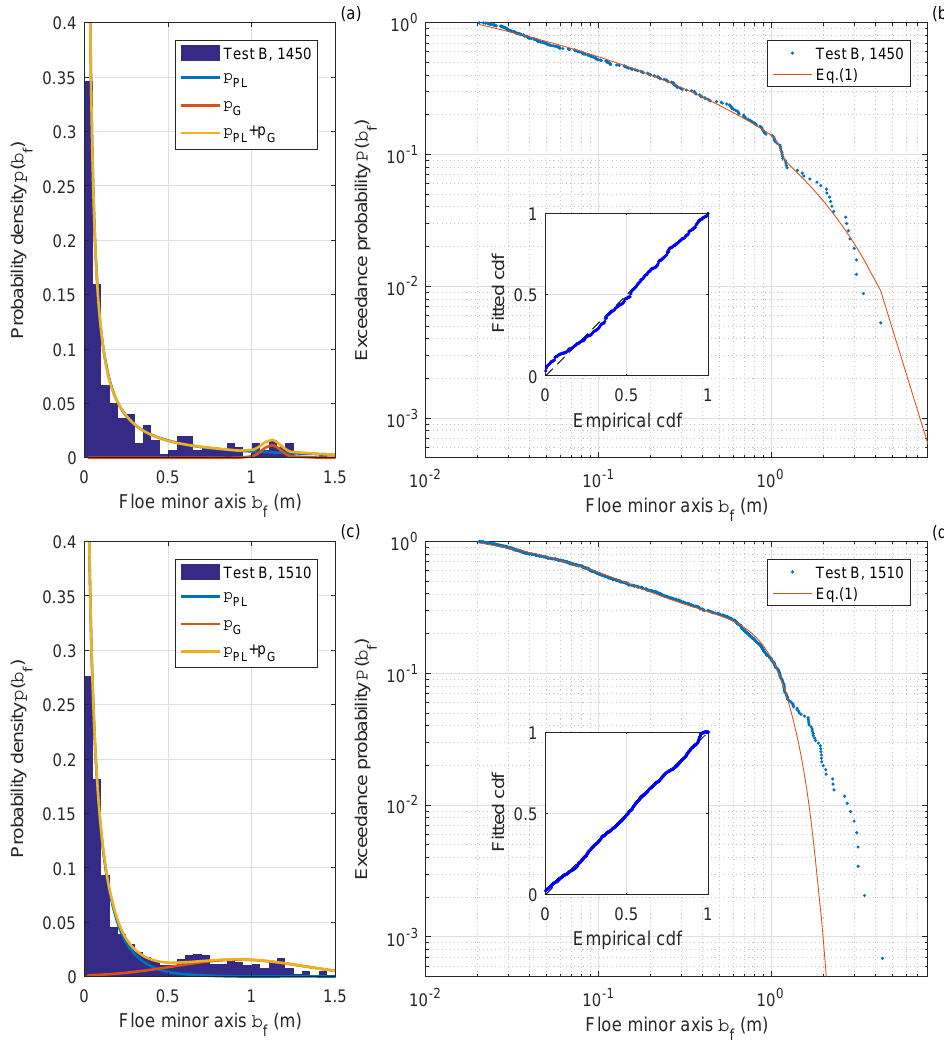
Figure 8. As in Fig. 7, but for test group